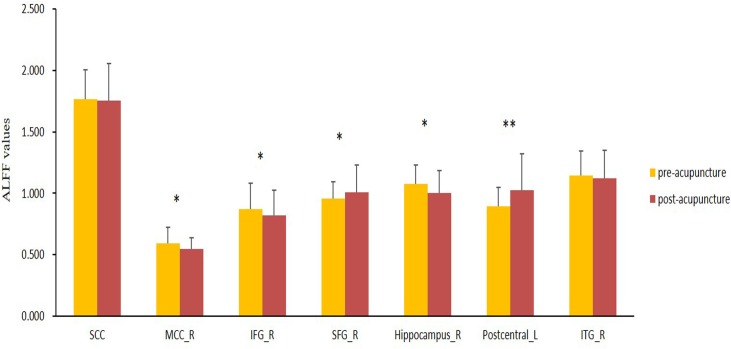
ALFF changes between post-acupuncture and pre-acupuncture in the AD patients, using the paired-samples T test analysis.SCC, subgenual cingulate cortex; MCC, middle cingulate cortex; IFG, inferior frontal gyrus; SFG, superior frontal gyrus; ITG, inferior temporal gyrus; **represents significantly changed ALFF in the AD patients when comparing post acupuncture with pre acupuncture (P<0.05); *represents slightly changed ALFF in the AD patients when comparing post acupuncture with pre acupuncture (P>0.05).